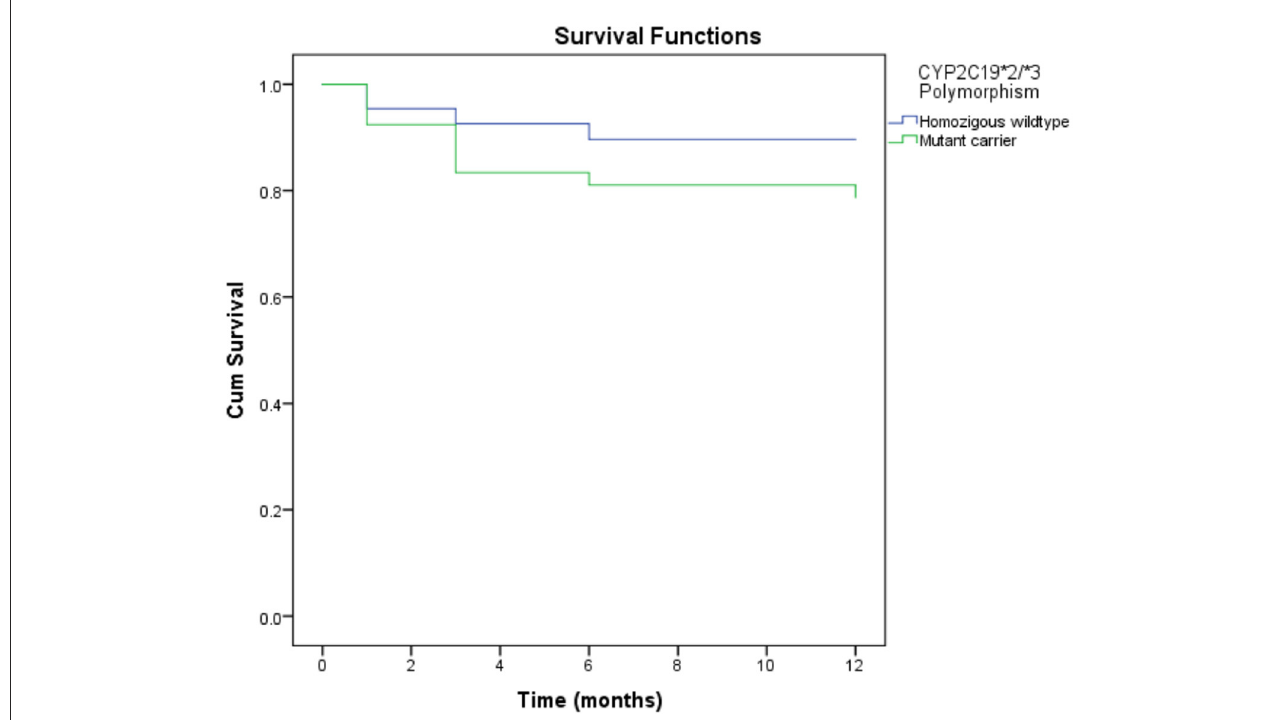
FIGURE1 Kaplan-Meier curves of MACE in 1 year according to CYP2C19*2 and CYP2C19*3 polymorphisms. Mutant carrier of CYP2C19*2/*3 polymorphism resulted in developing MACE faster than wild type in 1 year of observation (HR = 2.12, 95%CI = 1.01–4.46, P -value = 0.047). MACE, major adverse cardiovascular